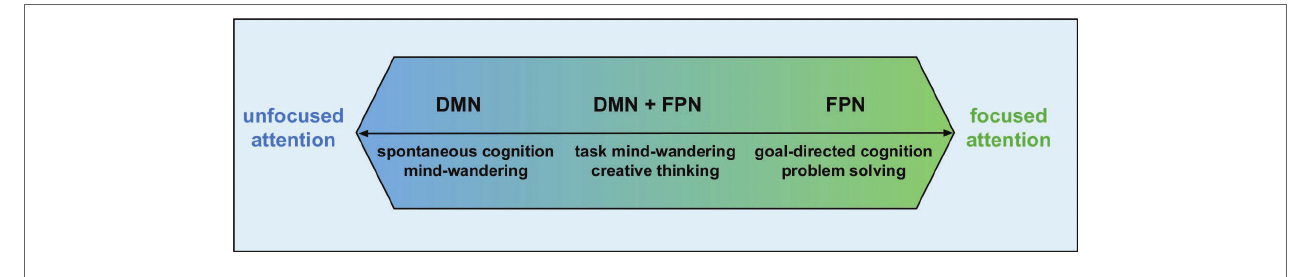
FIGURE 2 | Attention and activity of DMN and FPN (inspired by Christoff et al.,